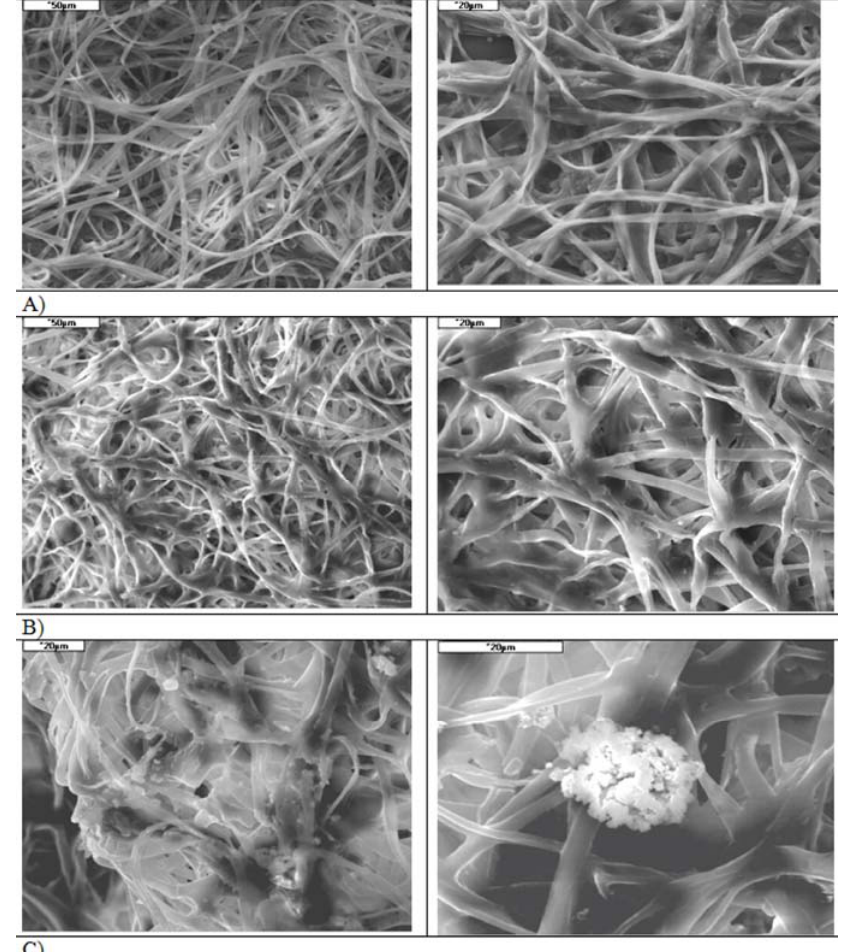
Figure 9. Microstructure and EDS of DBC/ZA:CA composite before and after incubation in PBS and SBF: ( A ) before incubation, ( B ) after incubation in PBS, ( C ) after incubation in SBF, ( D ) EDS analysis after incubation in